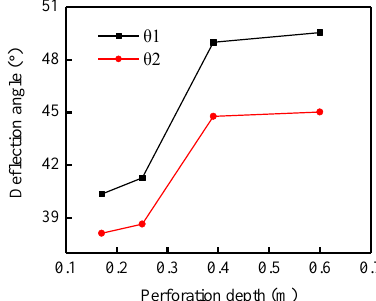
Figure 18. Relationship between perforation depth and two deflection angles ( θ 1 and θ 2 corresponding to quarter-length (10 m) and the half-length (20 m) deflection angle, respectively).